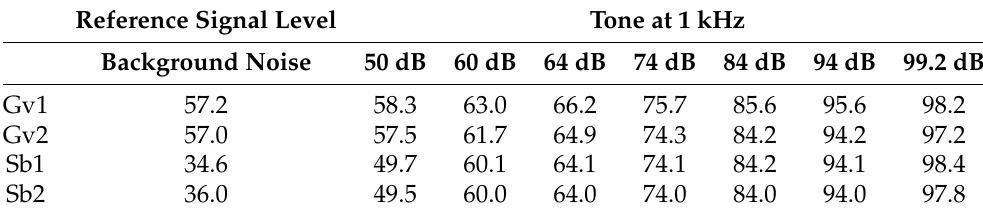
Figure 1. Set-up to measure the linearity of the two selected USB microphones. ( a ) Set-up with the speaker, the reference microphone and the evaluated microphones in the anechoic chamber. ( b ) Reference microphone (central microphone) and evaluated USB microphones (surrounding the central microphone) in the anechoic chamber. Table 2. Microphones linearity measurements.